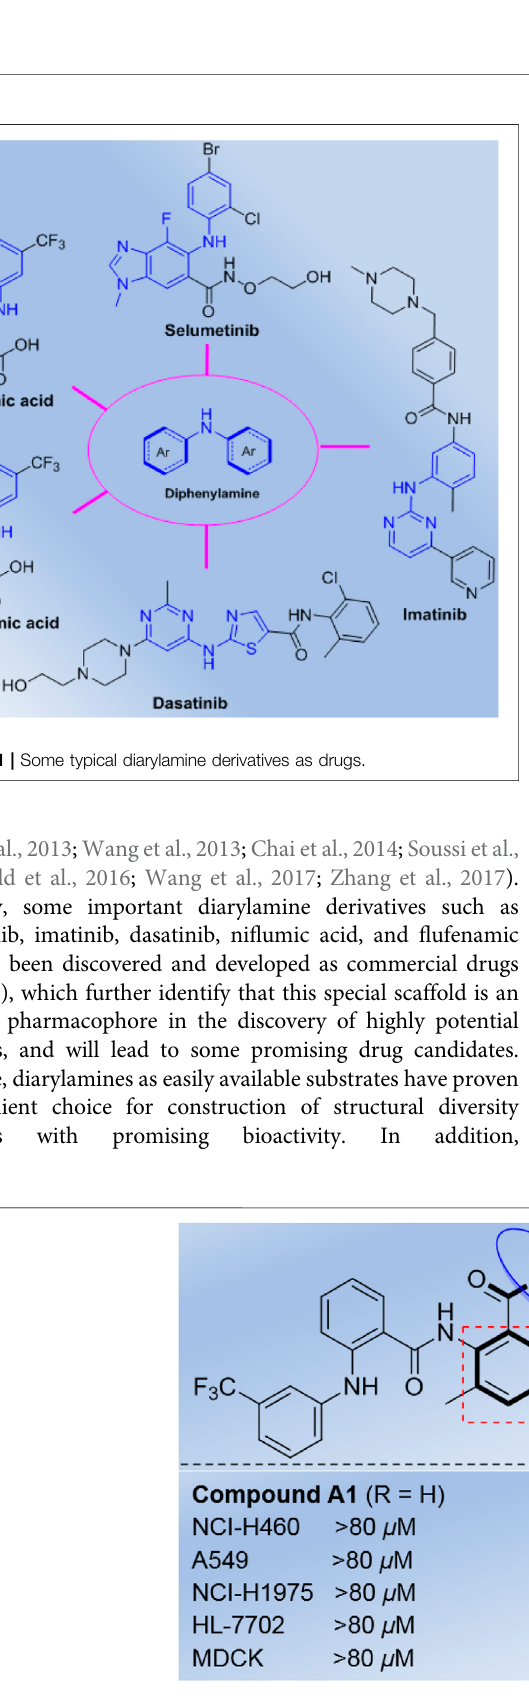
Frontiers in Chemistry |